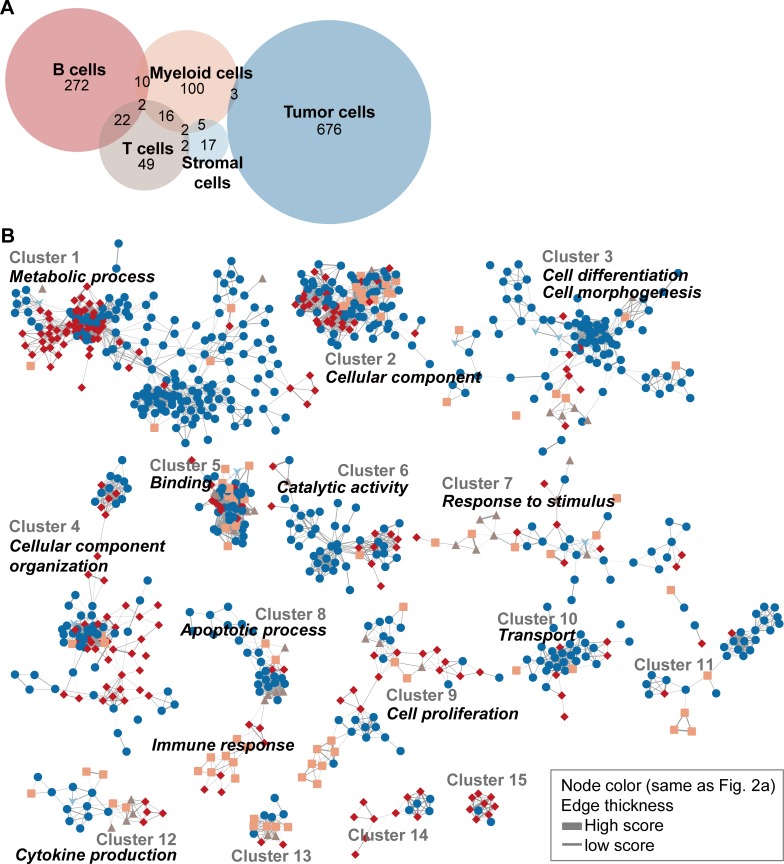
Cell type-specific functional categories associated with 3’UTR shortening and overexpression.(A) Venn diagram for 1,176 gene set hits specific to 5 cell types. Cell type specific gene sets were selected by correlation coefficient and odds ratio. (B) Network-based functional analysis of the selected gene sets. A total of 906 gene sets with sufficient interactions (> 0.5 Jaccard index and > 9 gene sets in a cluster) were selected for display. The cluster annotations of each gene set are available in S2 Table.